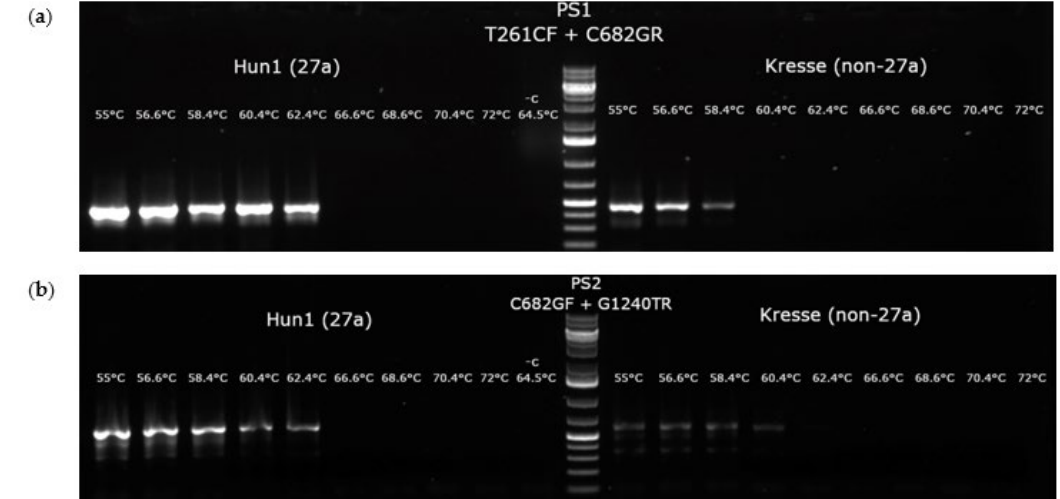
Figure 4. Gradient PCRs executed with PS1 and PS2 27a-specific asPCR primer pairs. PCRs were executed using Hun1 (member of 27a cluster) and Kresse (non-27a virus) templates with different Mg 2+ ion concentration. Only the best performances are shown; ( a ) the result of a gradient PCR with PS1 primer pair at 1.4 Mg 2+ (0.6 mM EDTA) concentration; ( b ) the result of a gradient PCR with PS2 primer pair at 1.8 Mg 2+ (0.2 mM EDTA) concentration.